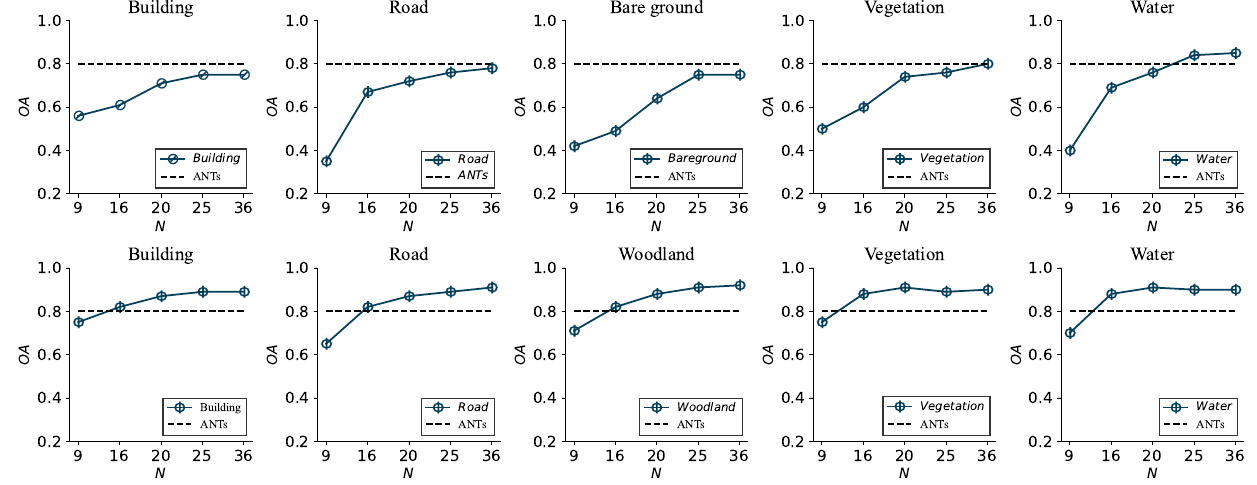
Figure 11. Classification accuracy on the two test images for each category.